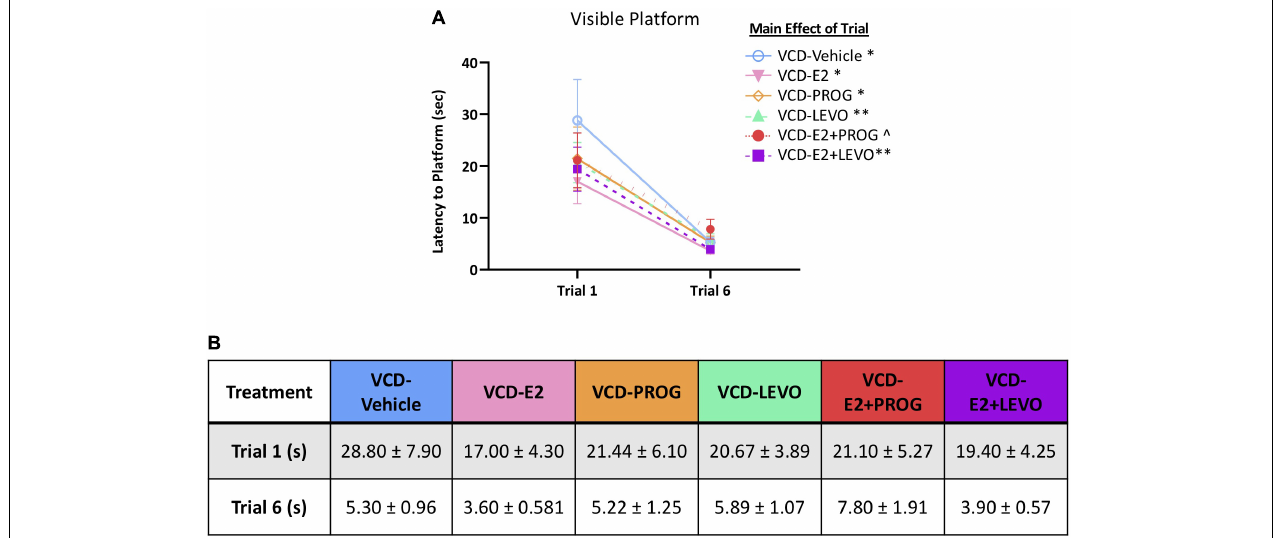
FIGURE 9 | Visible Platform. (A) All subjects decreased latency to platform from the first to last trial. (B) Trial times (means + S.E.M.) for each treatment group are provided. Significance: ∗ = p < 0.05, ∗∗ = p < 0.01, ˆ = p =